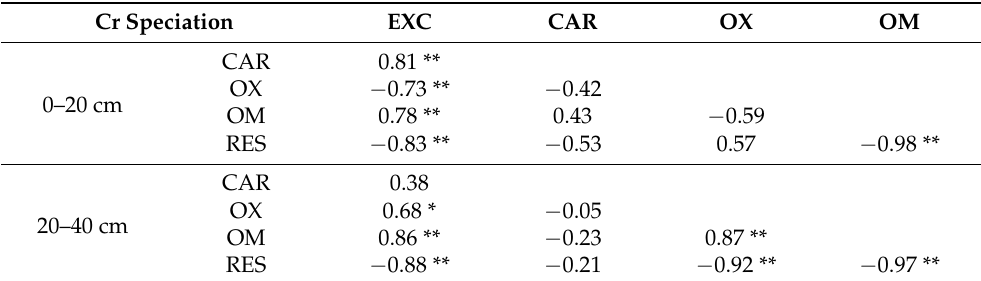
Table 4. Transformation of heavy metal Cr forms in surface soil during rice-rape